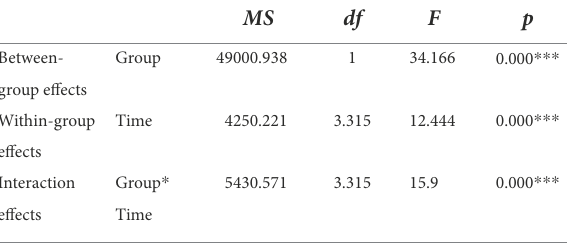
TABLE 7 Repeated measures analysis of variance for the length of